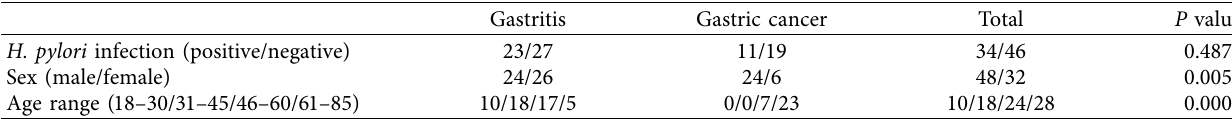
Table 2: Demographic data of patients in this study.